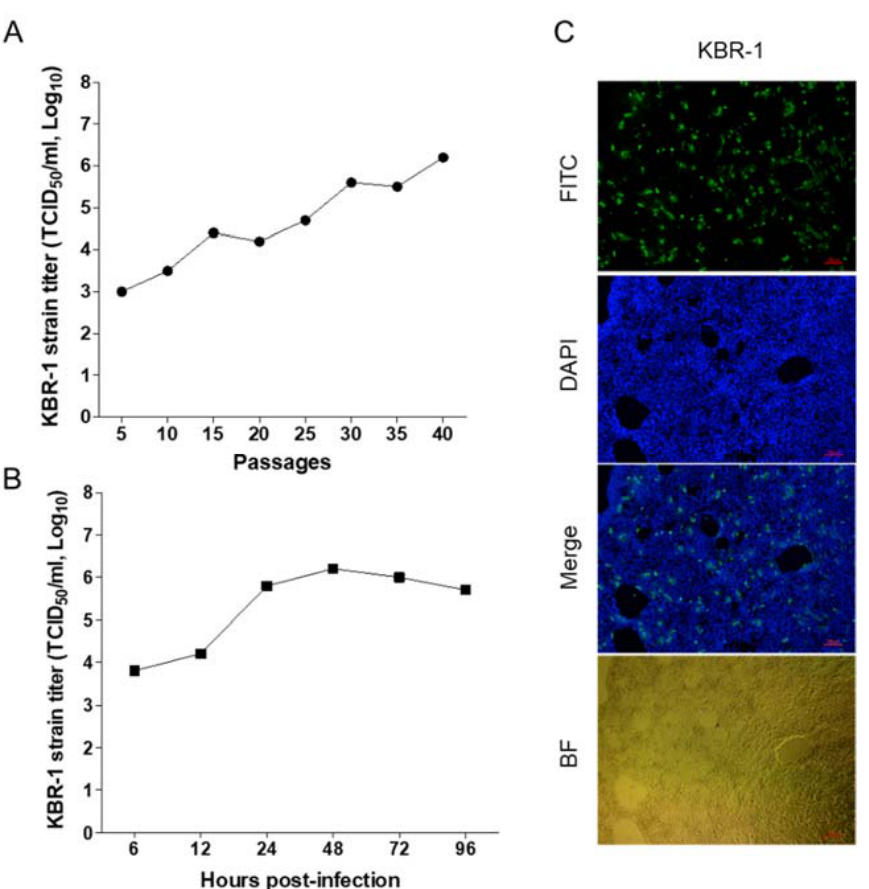
Figure 3. Proliferation and isolation of the KBR ‐ 1 strain using HRT ‐ 18 cells. Virus titer (according to passage number of the KBR ‐ 1 strain) detected in diarrhea samples from calves ( a ); virus titer at different times after inoculation with the KBR ‐ 1 strain ( b ); and virus detection and CPE (IFA, DAPI, merged images, and bright field microscopy) of the KBR ‐ 1 strain ( c ).